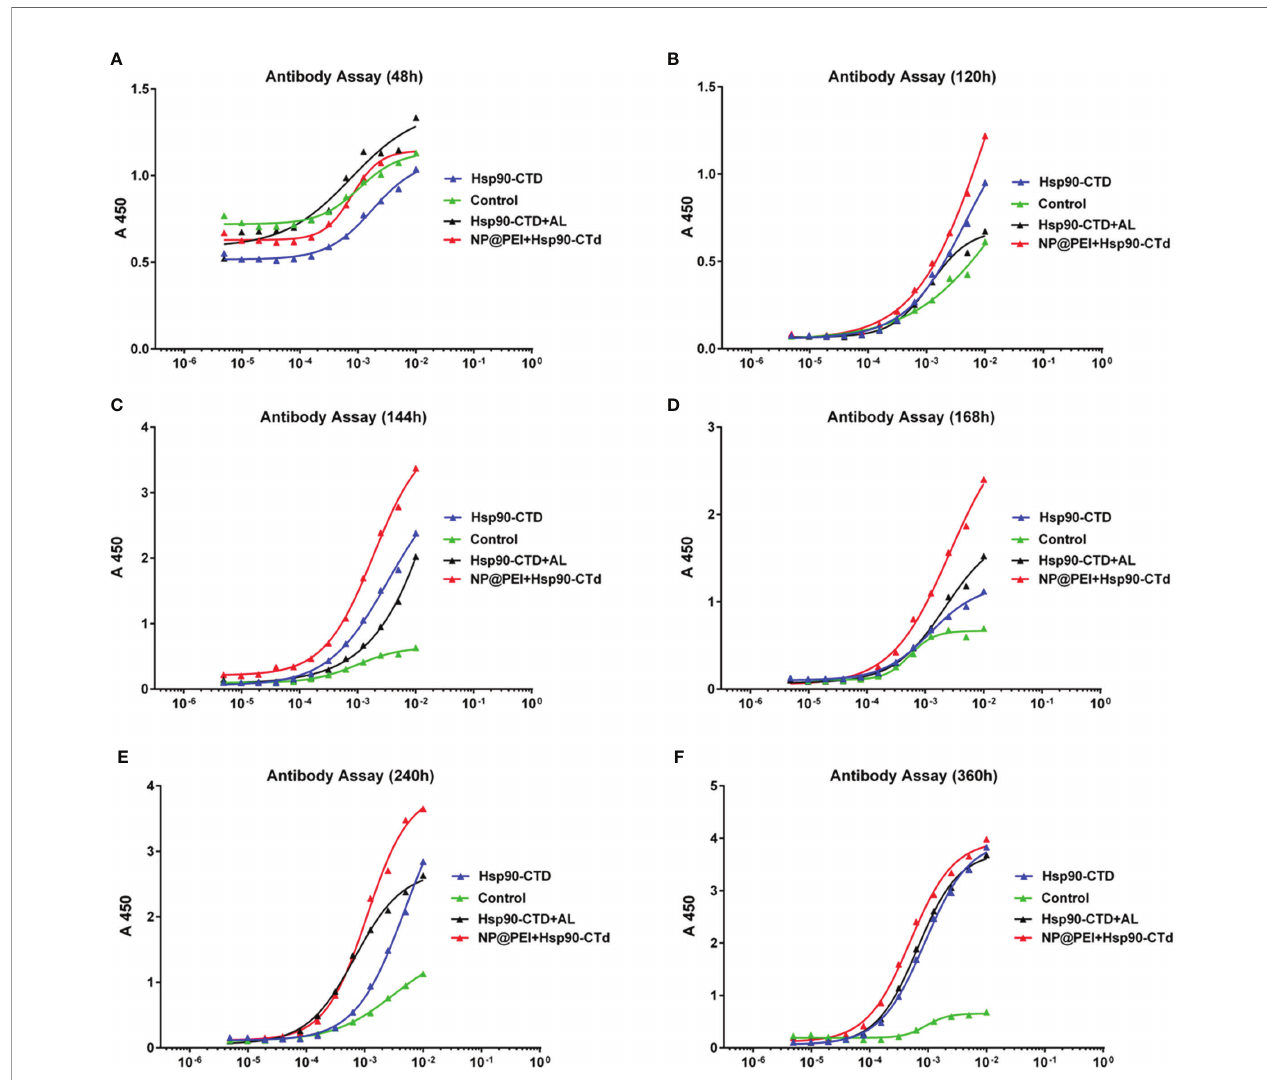
FIGURE 4 | Hsp90-CTD (1µg/ml) was coated into 96-well ELISA plates at 4°C overnight. Blood from 4 groups (control, Hsp90-CTD, Hsp90-CTD+AL, and NP) of mice was collected at different time points, 3 mice/group. Sera were obtained after centrifugation at 9000 rpm for 10 min. The sera were diluted 500 times and the antibody levels were then measured by ELISA. (A) 48 h (B) 120 h (C) 144 h (D) 168 h (E) 240 h (F) 360